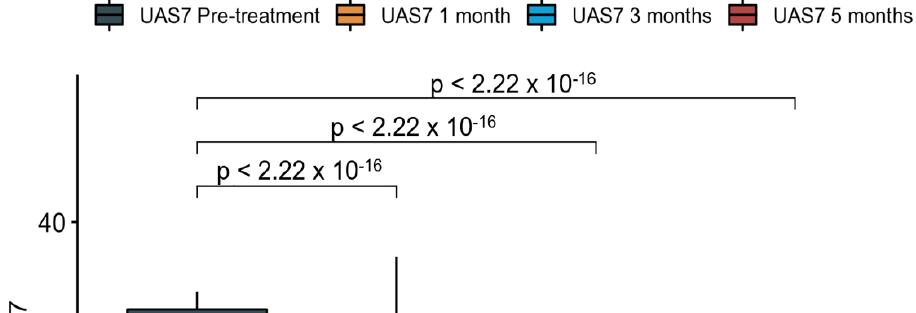
Figure 2. UAS7 Flow diagram according to CSU patient groups.